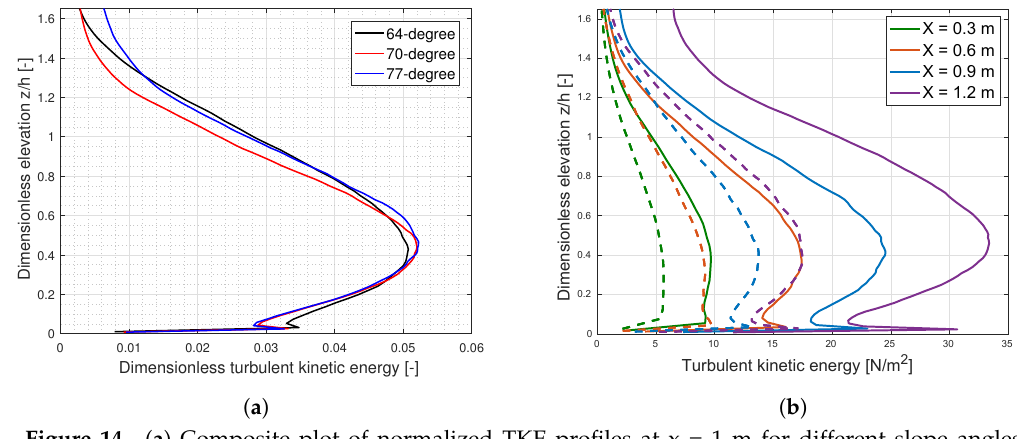
Figure 14. ( a ) Composite plot of normalized TKE profiles at x = 1 m for different slope angles; ( b ) Composite plot of TKE profiles spaced by a distance of 0.3 m: dashed lines correspond to 64 ◦ breach face and solid lines correspond to 77 ◦ breach